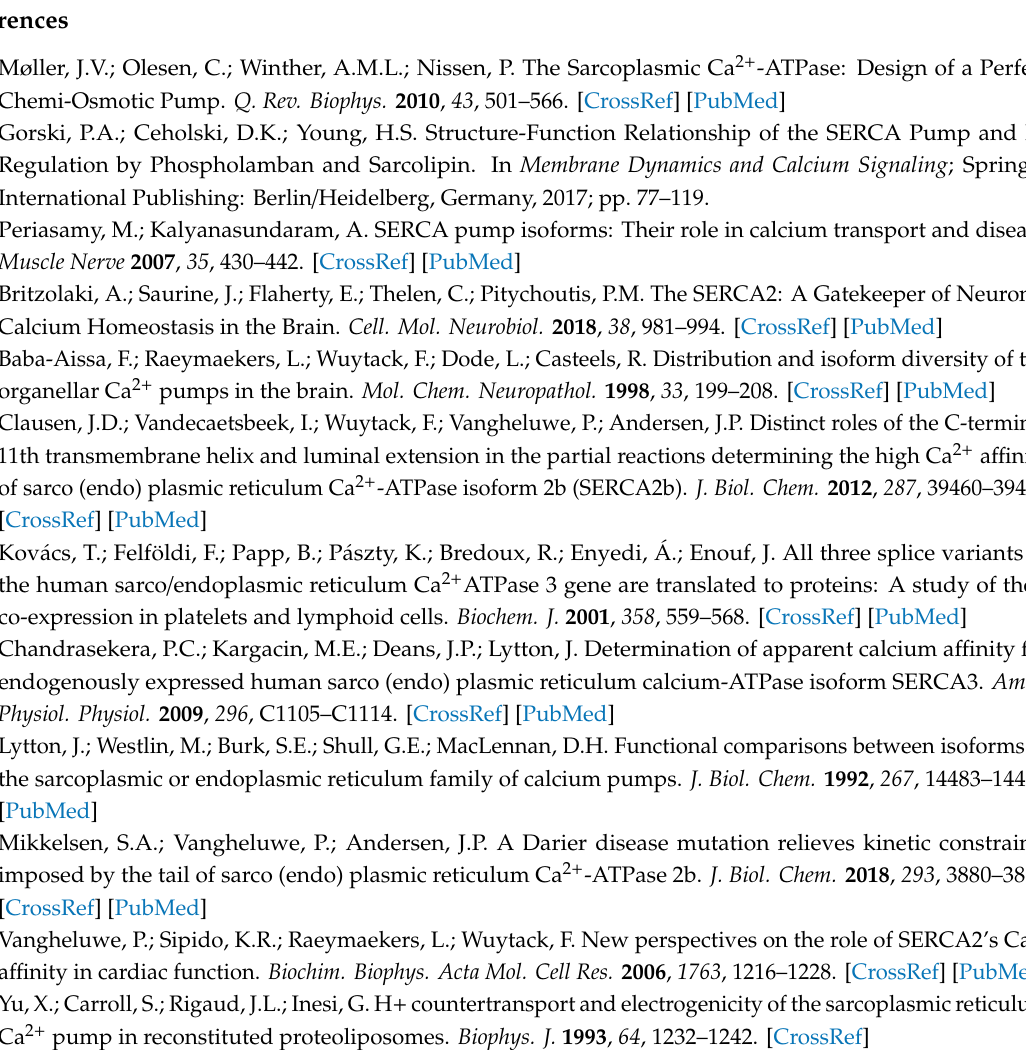
Figure B4. Interhelical angle of selected SERCA TM helix pairs.